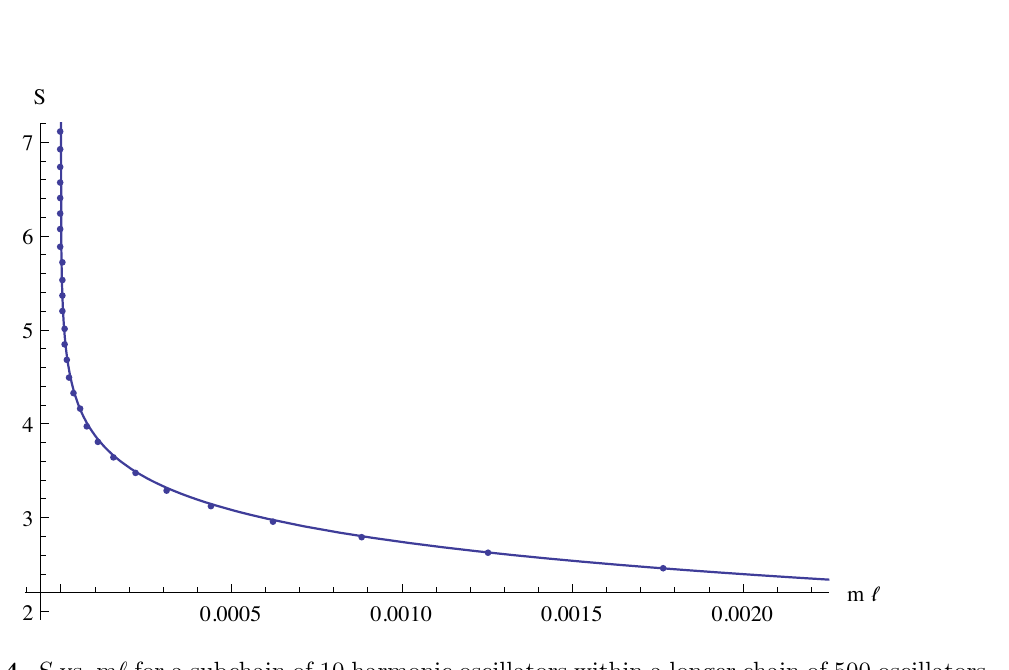
Figure 4 . S vs. m ‘ for a subchain of 10 harmonic oscillators within a longer chain of 500 oscillators with periodic boundary conditions.